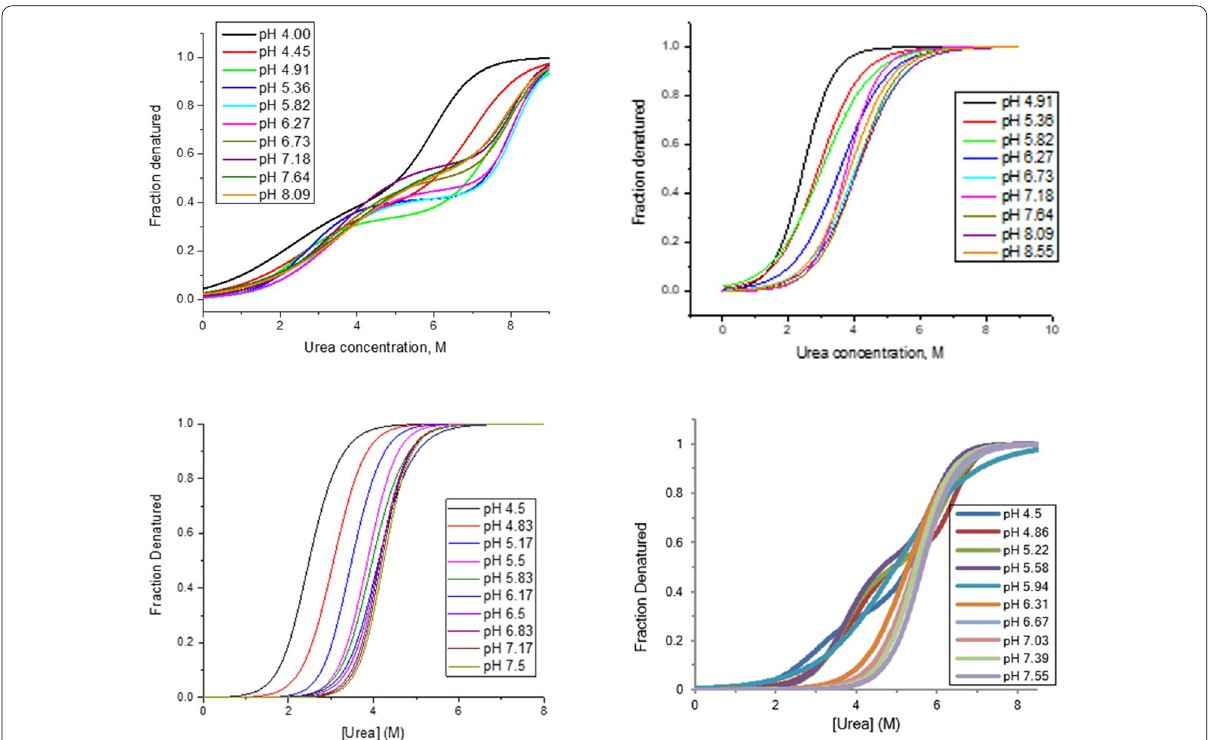
Fig. 1 Leveraging Historical Data ‑ Effect of pH on Viral Fusion Proteins (FusProtX). Excerpt from Kueltzo, L., Vaccine Development Challenges in a Pandemic Setting: Formulation and Stability Considerations, AAPS Vaccine Stability Workshop, March 24‑25,